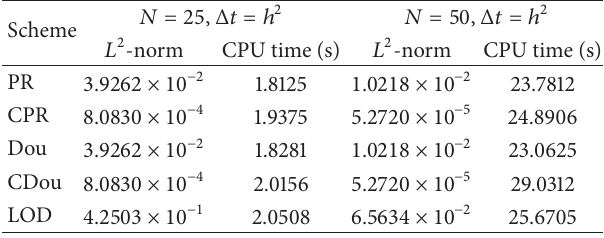
Table 3: The 𝐿 2 -norm and CPU time for all schemes. Scheme